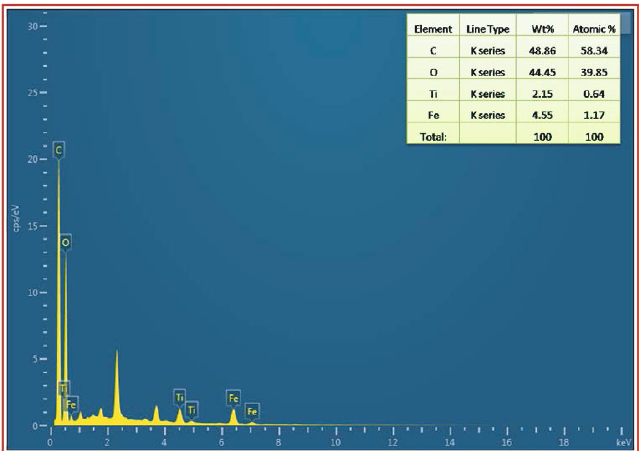
Figure 5: EDX spectrum of as synthesized GFT nanocomposite.